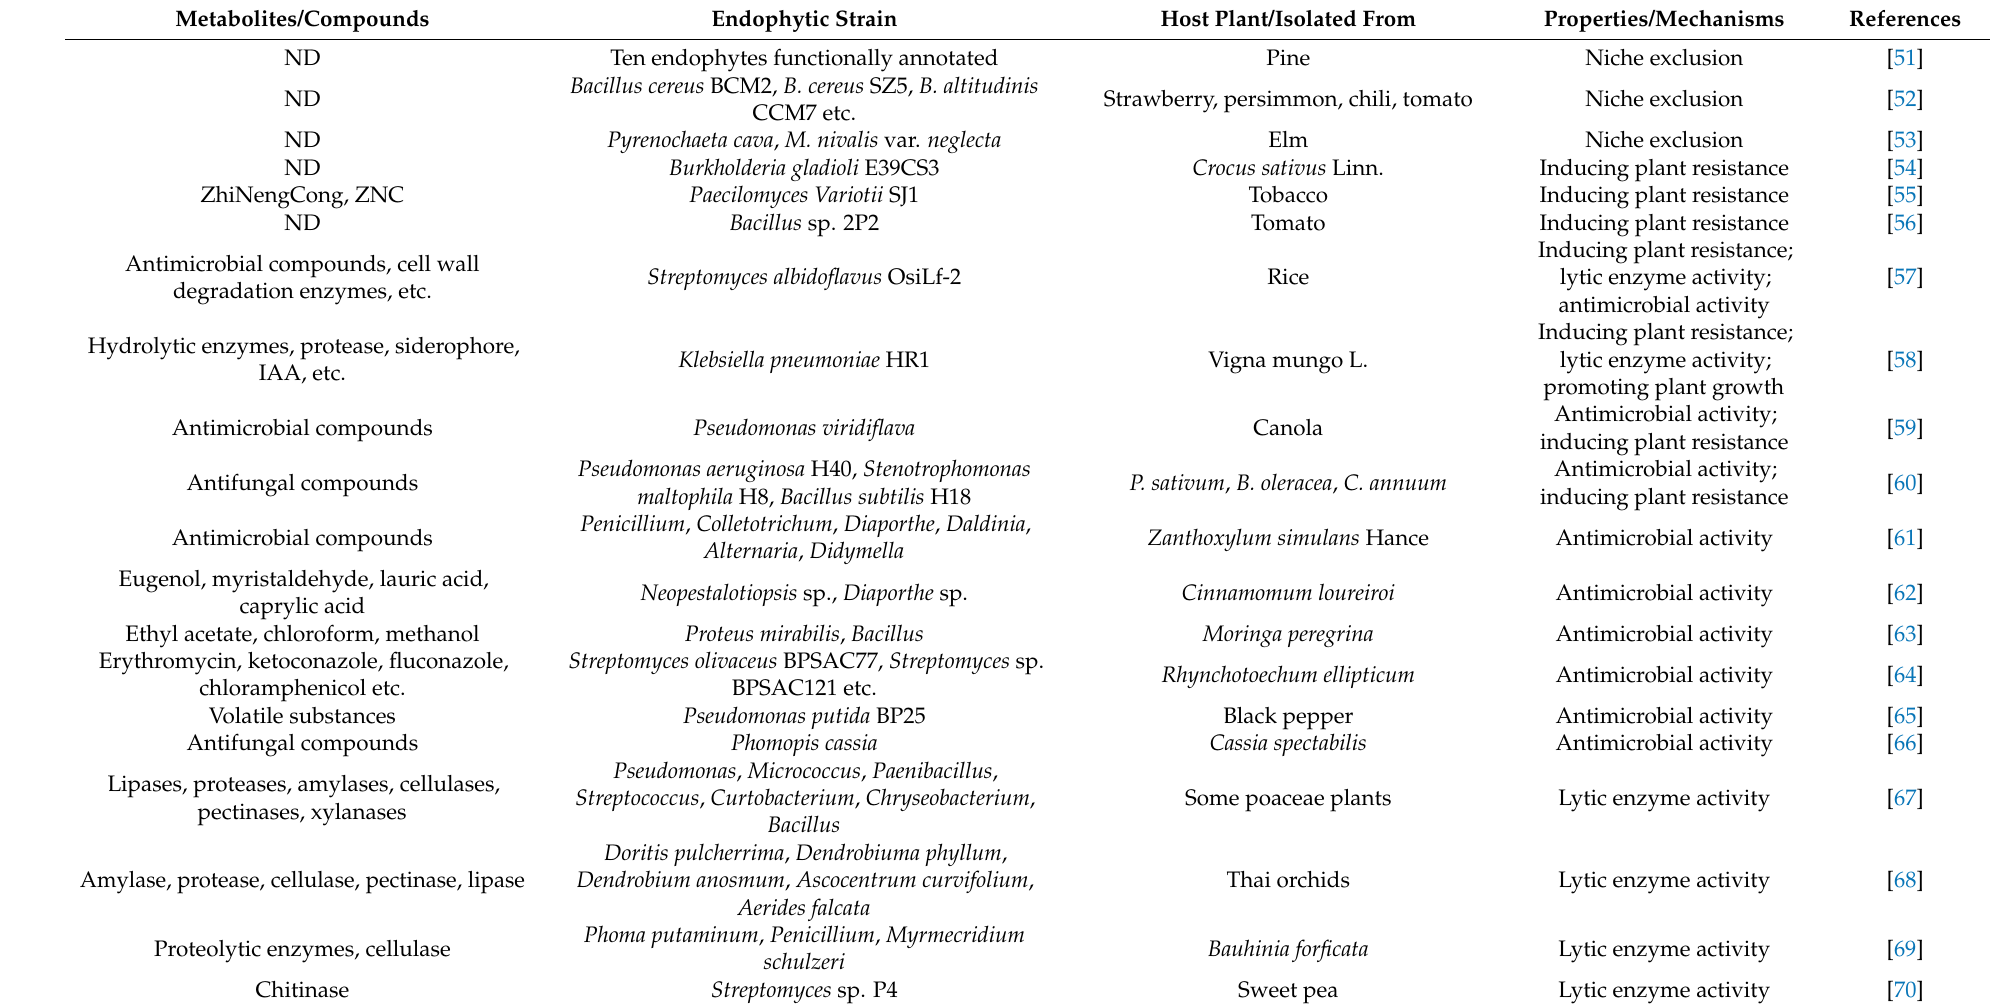
Table 1. Endophytes and their metabolites used in biological control of plant